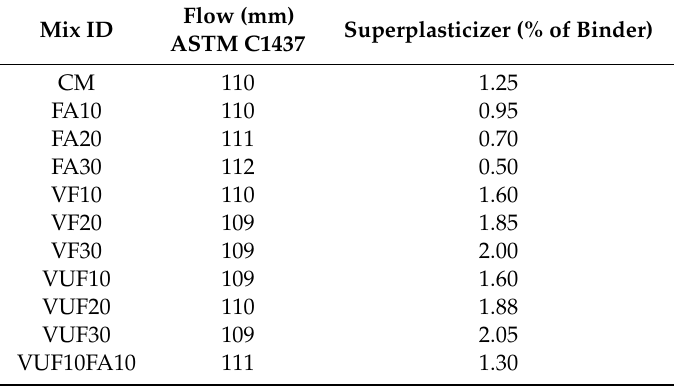
Table 2. Flow properties of mortar mixes.